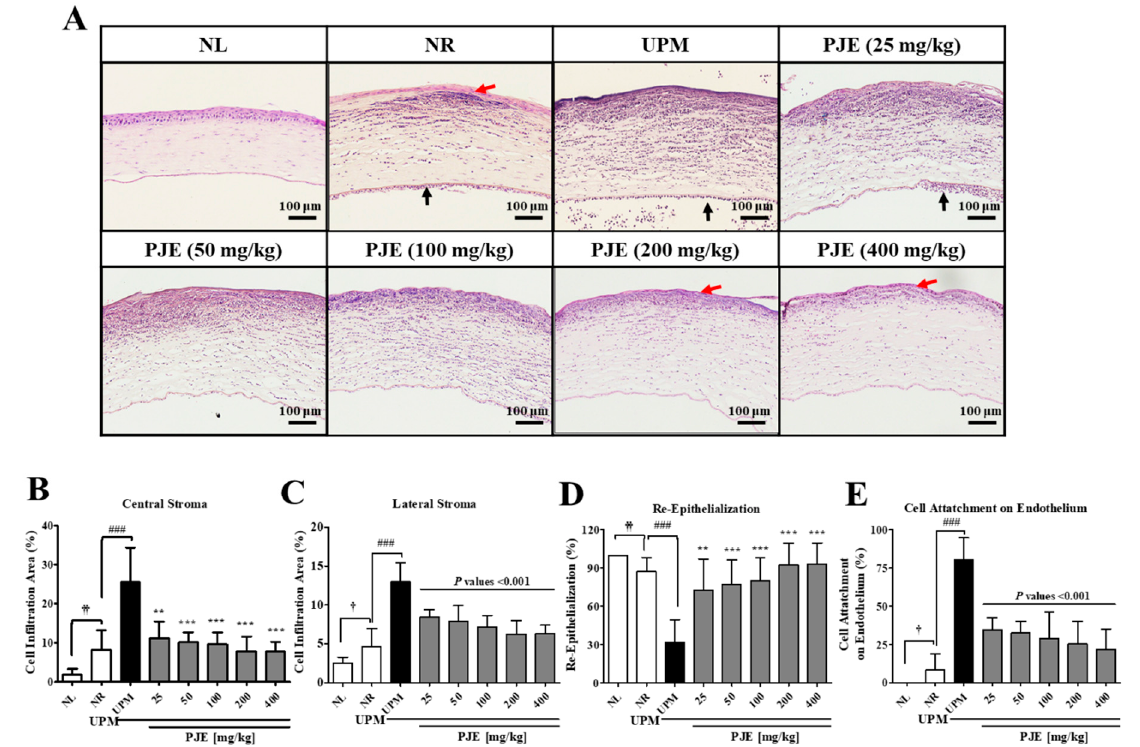
Figure 6. Histological changes during corneal wound healing after treatment with PJE and after UPM exposure. ( A ) Images of hematoxylin and eosin (H&E) staining of the cornea at 72 h were acquired at 200 × magnification, and representative images are shown. Red arrow, re-epithelialized epithelium; black arrow, cell attachment on the endothelium. The infiltration of immune cells in ( B ) the central stroma and ( C ) the lateral stroma, ( D ) the re-epithelialization rate and ( E ) cell attachment to the endothelium were calculated, and the results are presented as the means ± SD. † p < 0.05, †† p < 0.01 compared to NL; ### p < 0.001 compared to NR; ** p < 0.01, *** p < 0.001 compared to UPM.